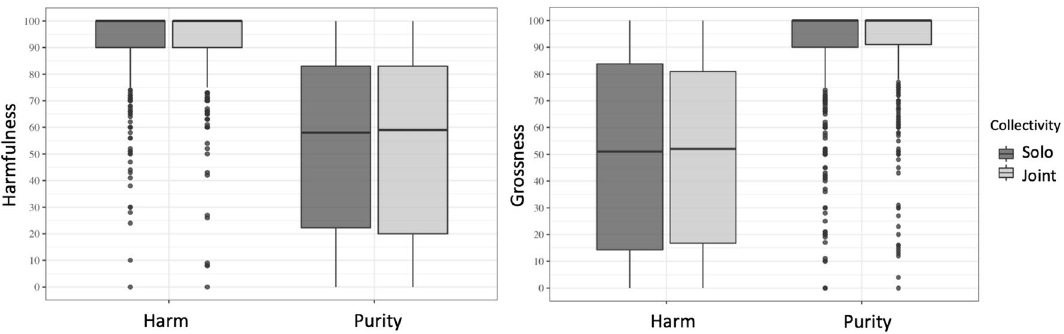
Figure 5. No difference in punishment judgments was observed between Solo and Joint Purity violations in Experiment